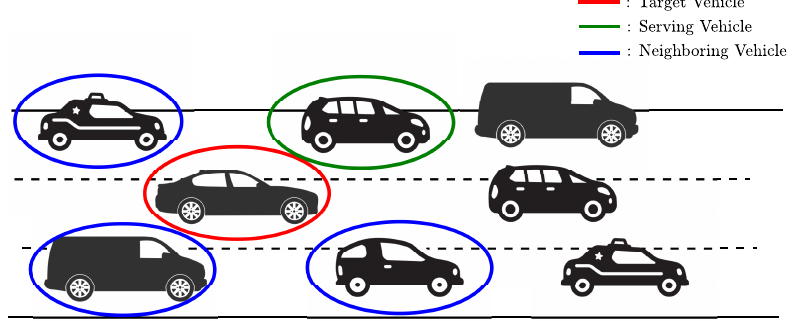
Figure 1. System model with multiple